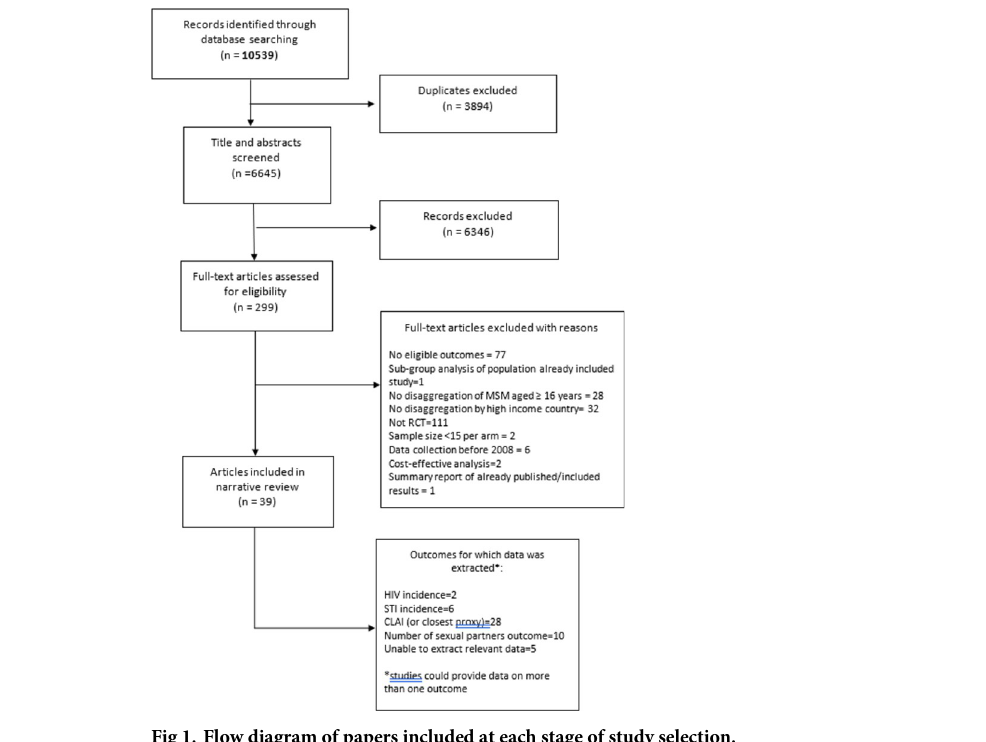
Fig 1. Flow diagram of papers included at each stage of study